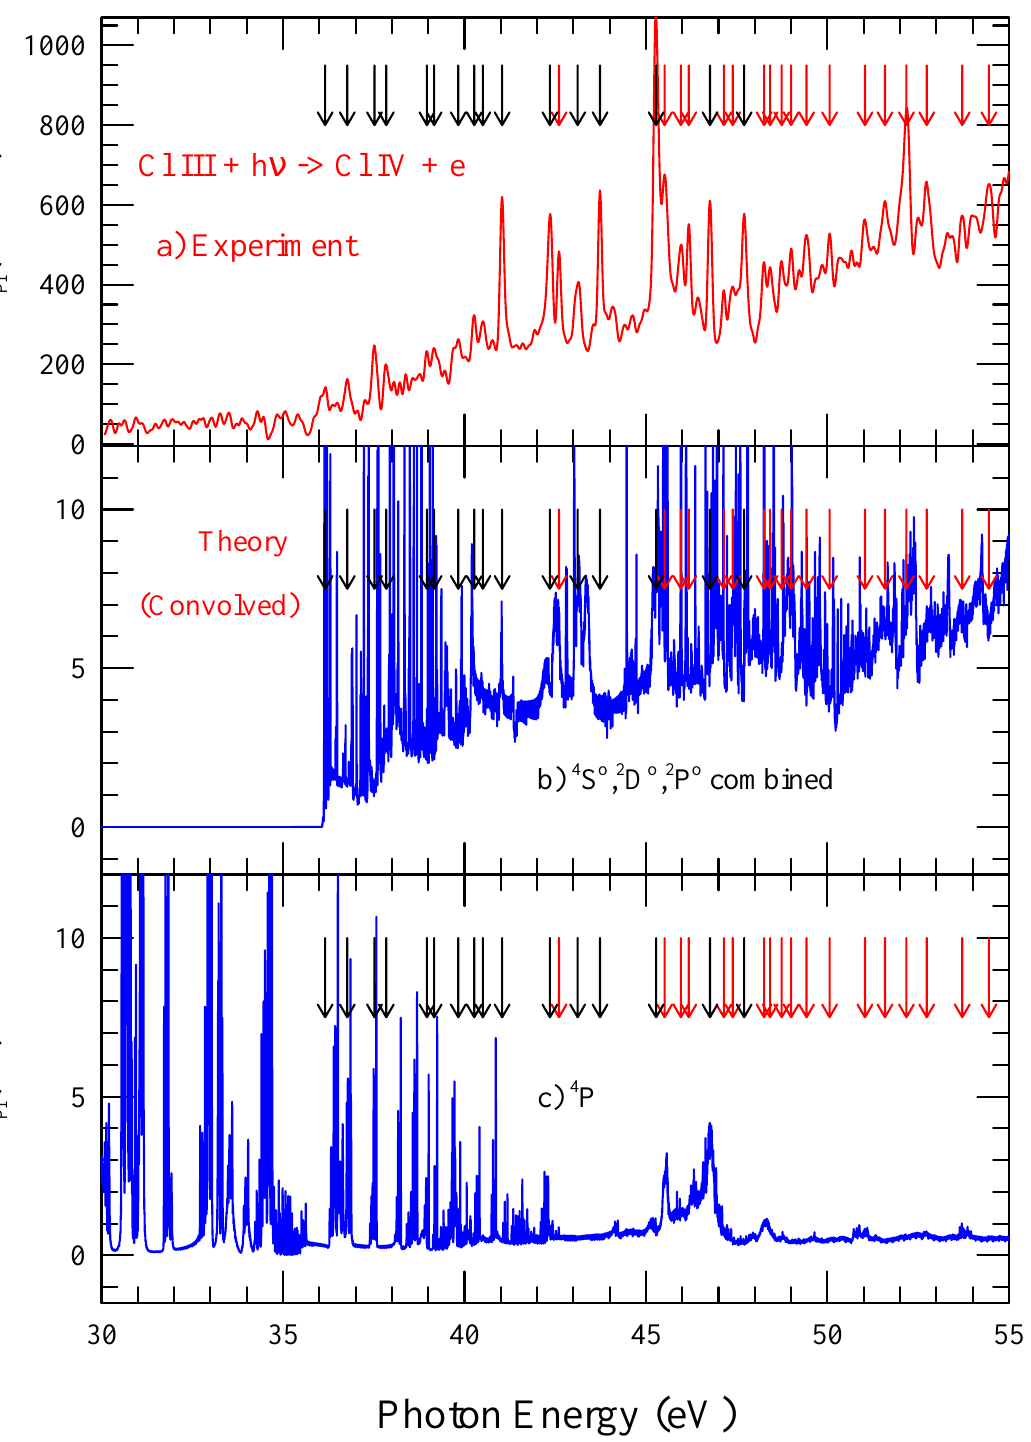
Figure 3. (Color online) Calculated single-photon photoionization (convolved with the Gaussian profile of the experimental beam-width) ion-yield spectrum of Cl III into Cl IV (blue). The top panel corresponds to the measured spectrum of Figure 1 (red). Panel ( b ) presents the summed features from the convolved σ PI of the lowest five initial levels of states 4 S ◦ , 2 D ◦ and 2 P ◦ only. Panel ( c ) corresponds to the sum σ PI of the three 4 P initial levels